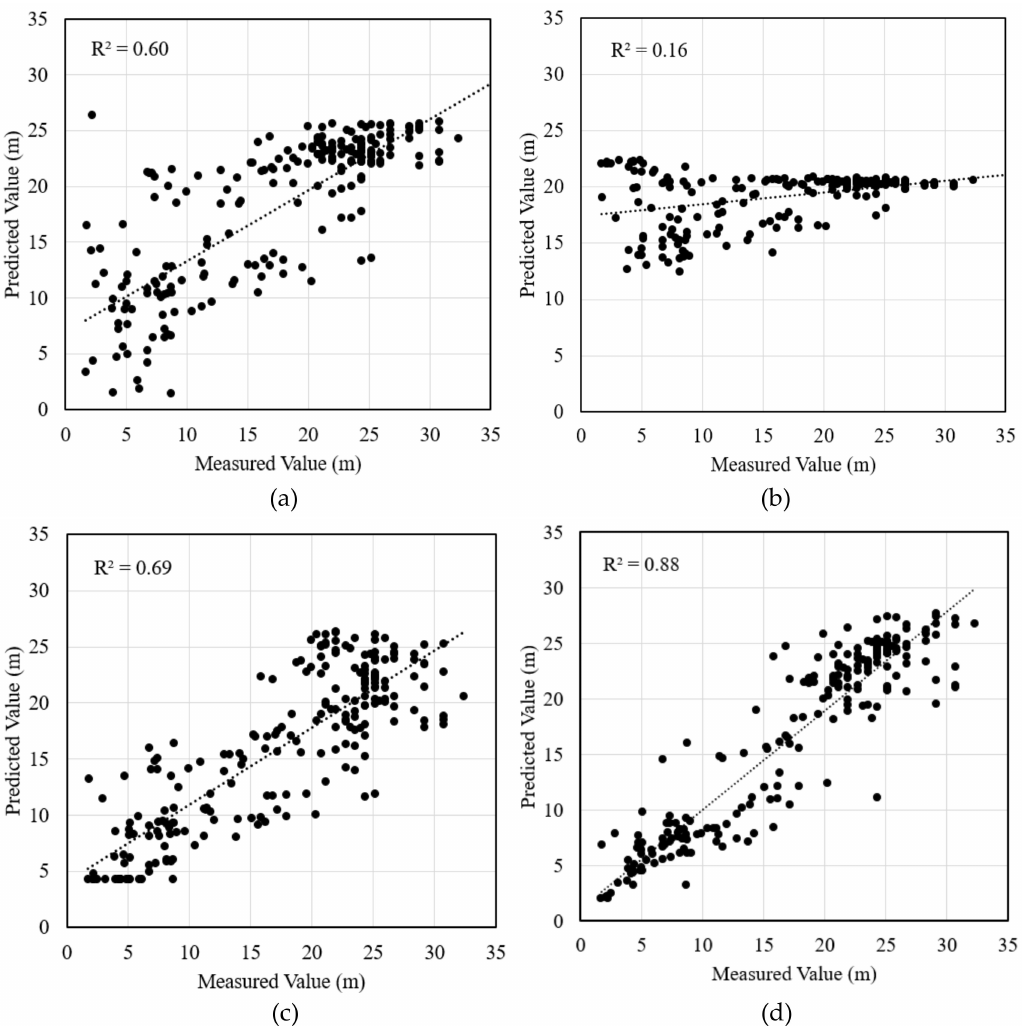
Figure 9. Comparison of the inverted depths and the observed depths: ( a ) the scatter plot of the log-linear model results; ( b ) the scatter plot of the Stumpf model results; ( c ) the scatter plot of the MLP model results; ( d ) the scatter plot of the GRU model results.